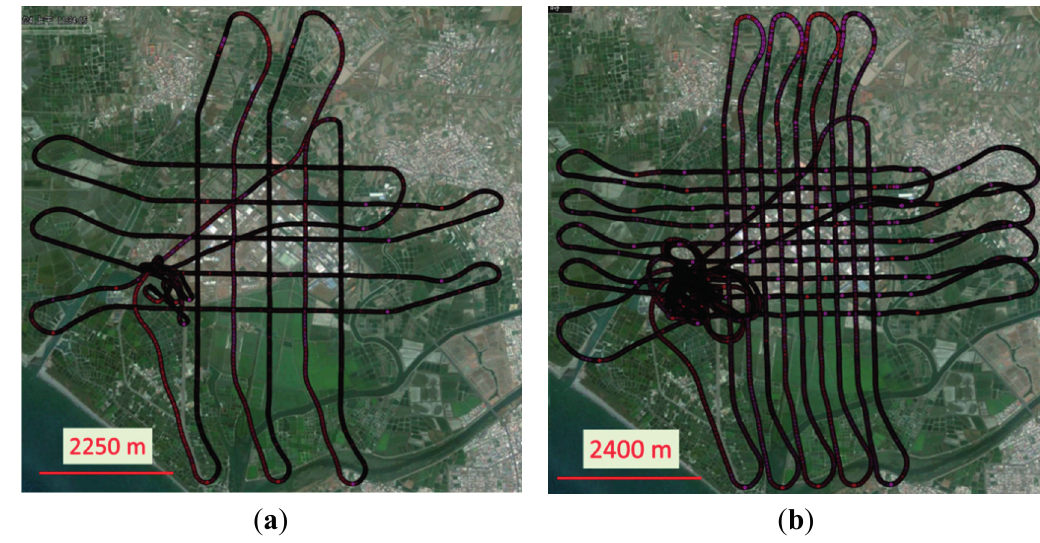
Figure 19. The trajectories of the first test flight. ( a ) UAV-MMQG-600; ( b ) UAV-MMQG-300.